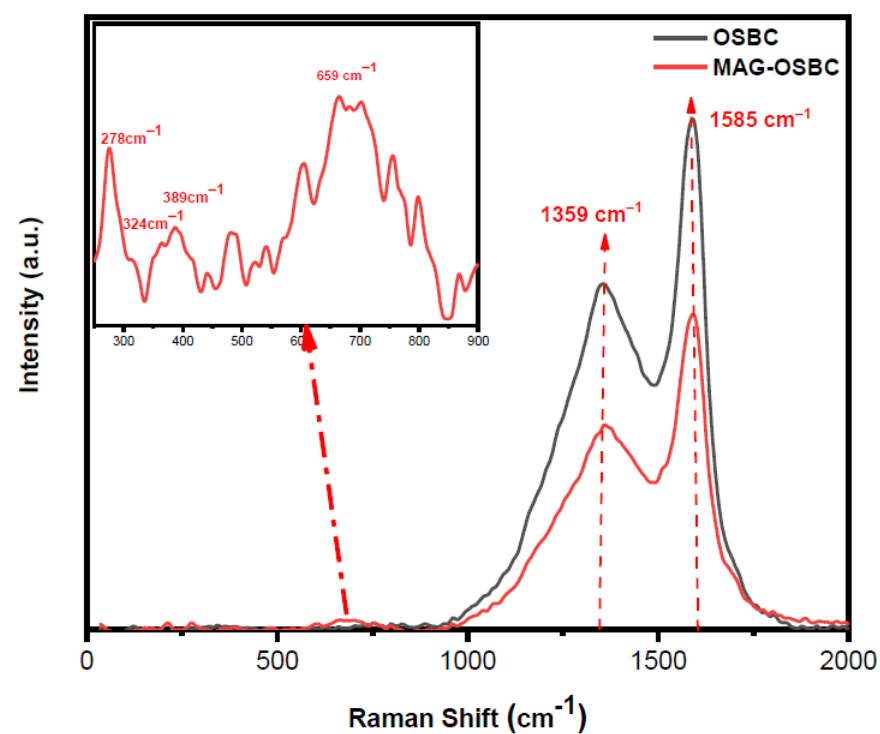
Figure 3. Raman spectra of OSBC and MAG–OSBC .